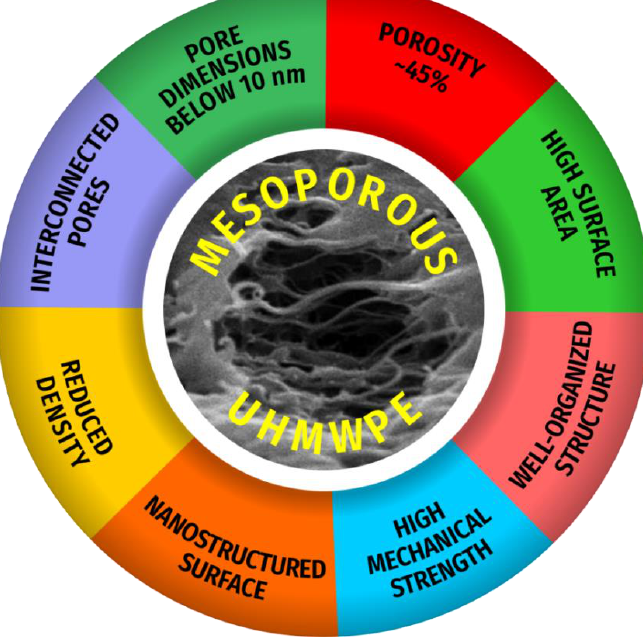
Figure 9. Structural characteristics of MP UHMWPE materials.